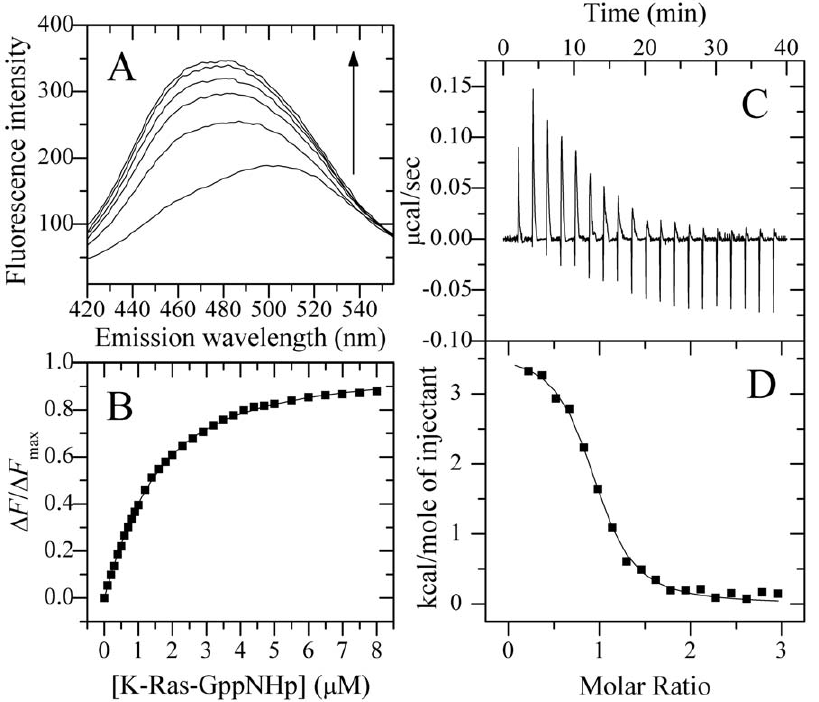
Figure 2. Interaction of K-RasB with Ca 2 + /CaM at 25.0 6 C. Fluorescence spectra (A) of 1.0 m M dansyl-CaM in the absence and in the presence of K-RasB-GppNHp at different concentrations. The arrow represents the concentration of K-RasB-GppNHp increases gradually from 0 (the bottom) to 8.0 m M (the top). D F / D F max for the binding of K-RasB-GppNHp to Ca 2 + /CaM plotted as a function of the concentration of K-RasB-GppNHp (B). The solid squares were the experimental data and the solid line represented the best fit. The panel C represents typical calorimetric titration of K-RasB- GppNHp (20.0 m M) with CaM (300 m M) in the presence of 1 mM CaCl 2 . The panel D shows the plots of the heat evolved (kcal) per mole of CaM added, corrected for the heat of CaM, against the molar ratio of CaM to K-RasB. The data (solid squares) were fitted to a single set of identical sites model and the solid line represented the best fit. The corresponding parameters from B and D are summarized in Table 1.